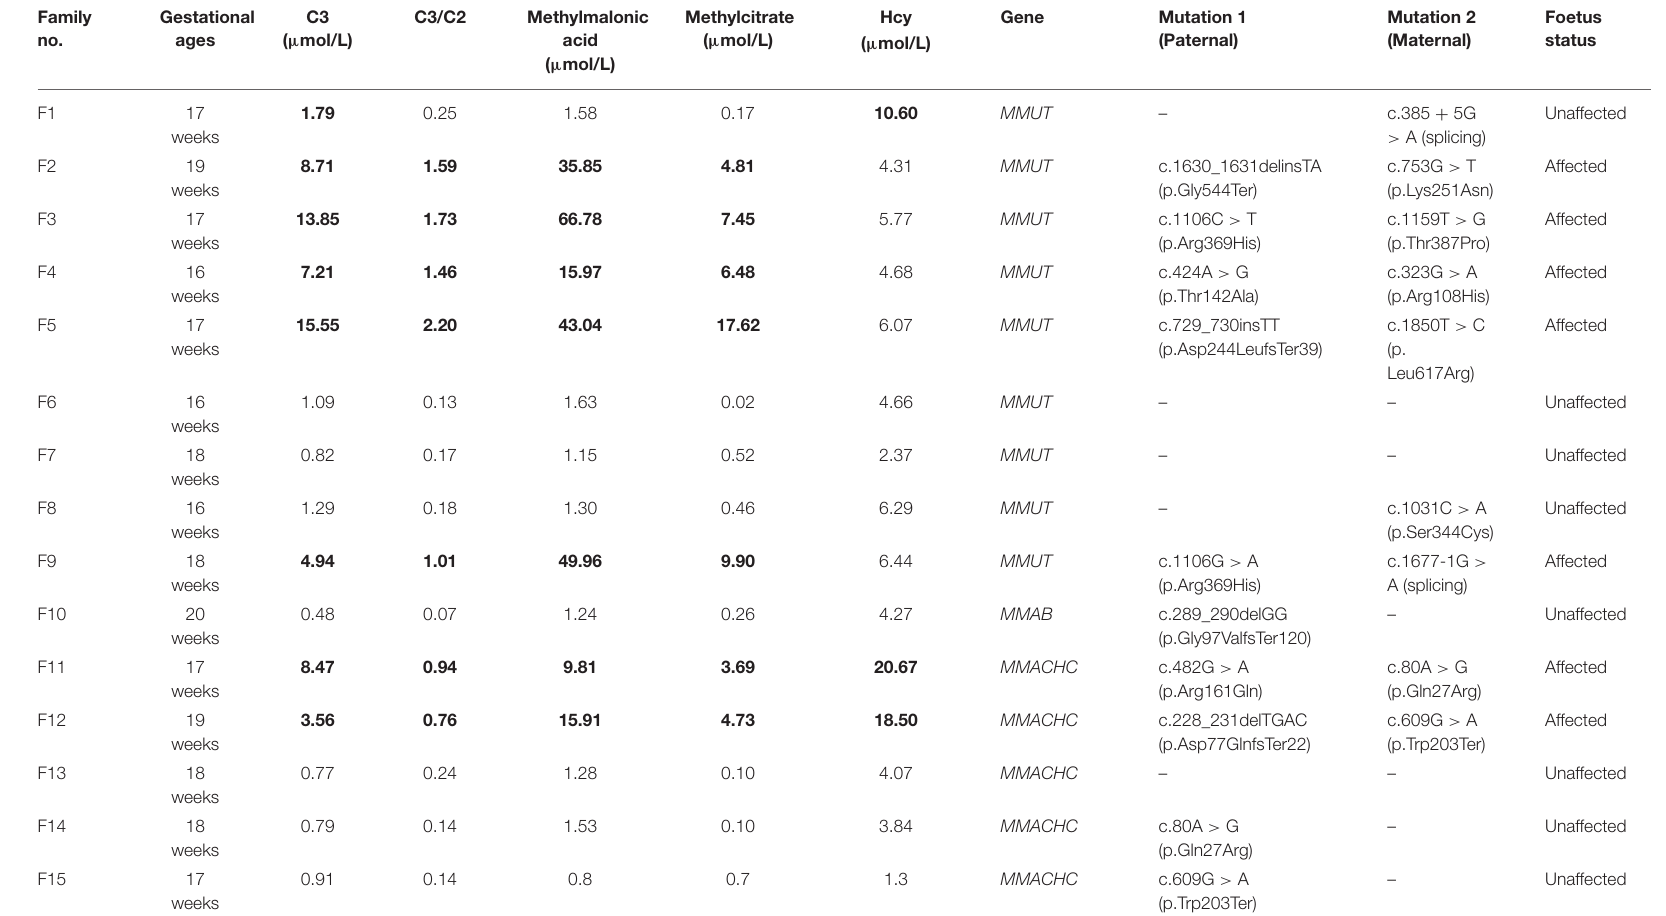
TABLE 2 | The characteristic metabolite levels and DNA sequencing results in the amniotic fluid samples of 15 foetuses from MMA families referred. Family